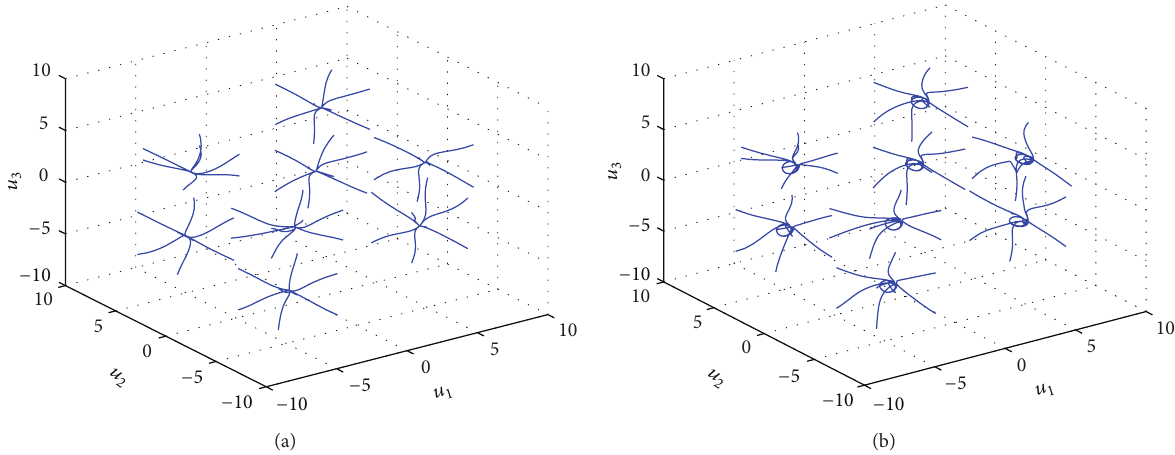
Figure 2: Transient behaviors of the state variables 𝑢 1 (𝑡) , 𝑢 2 (𝑡) , and 𝑢 3 (𝑡) with different initial values in Example 2.